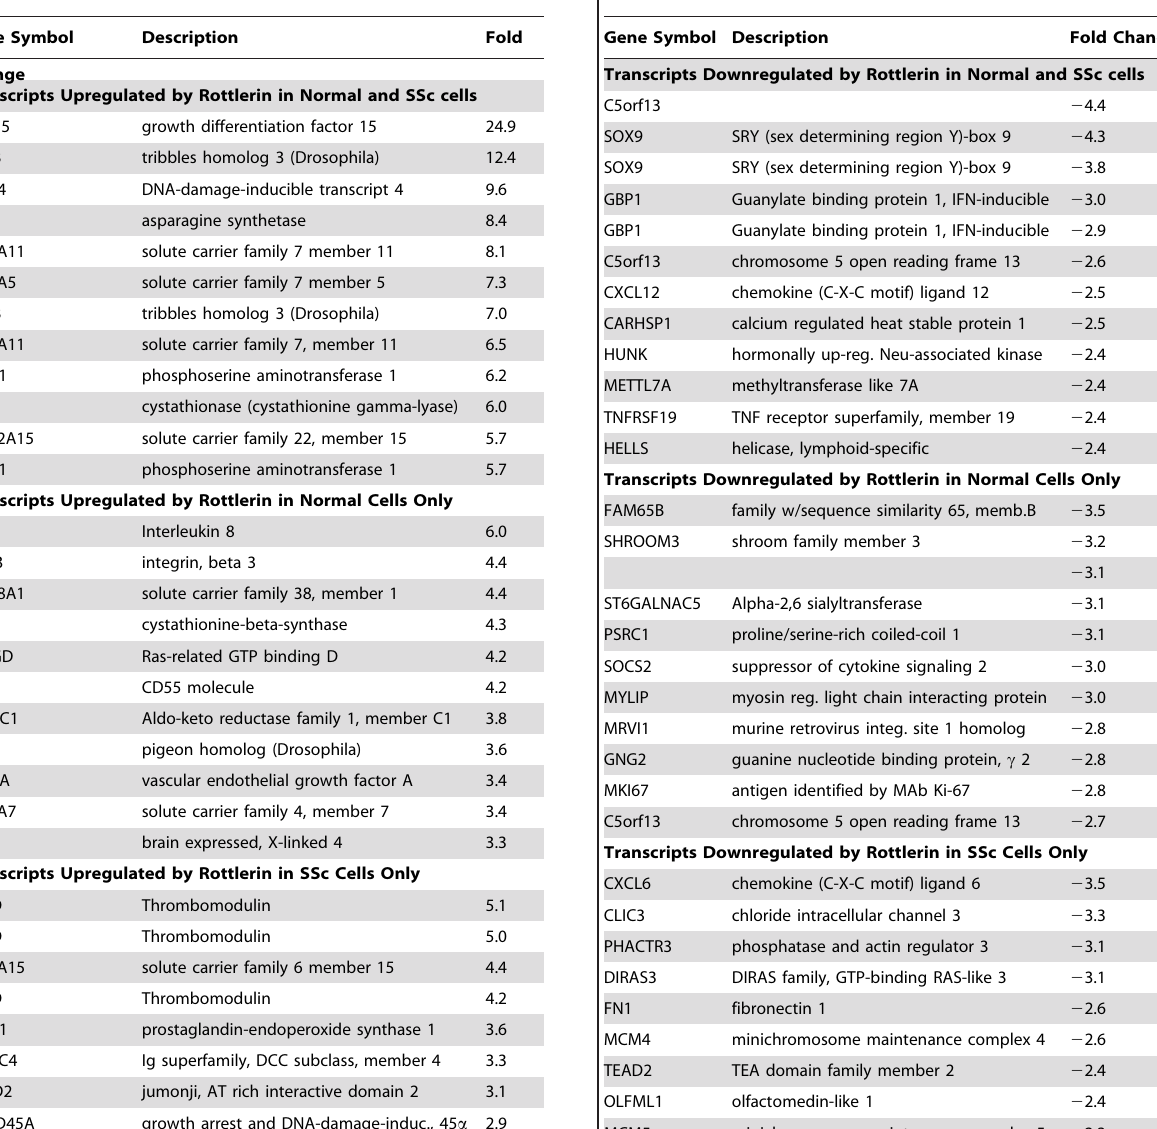
Gene Symbol Description Fold Change